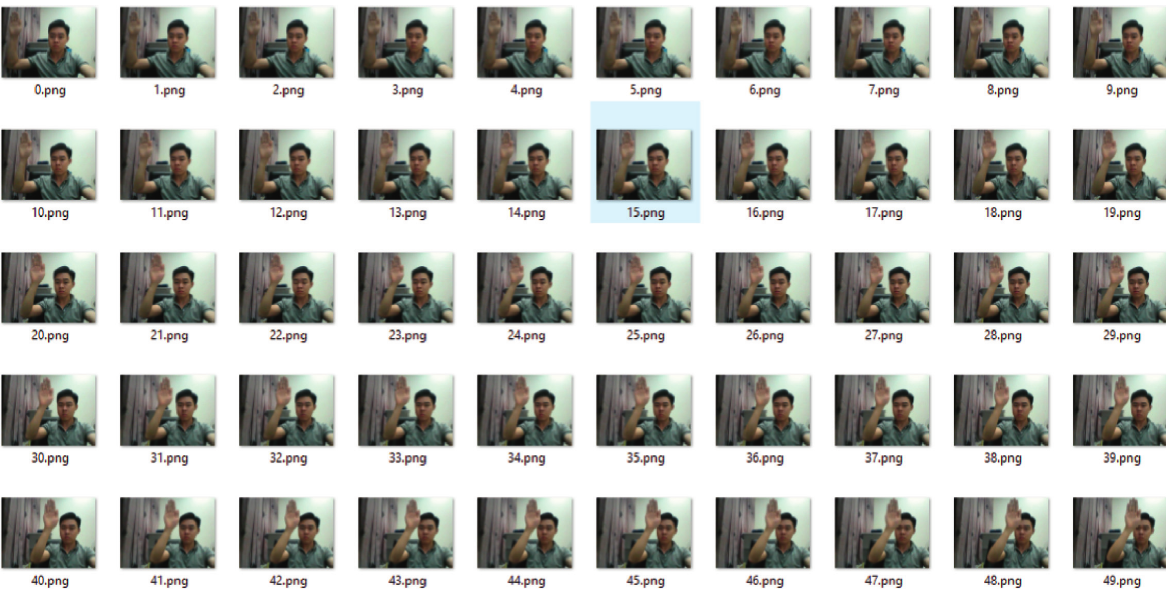
Figure 10: Dataset contains hand patterns in different positions.